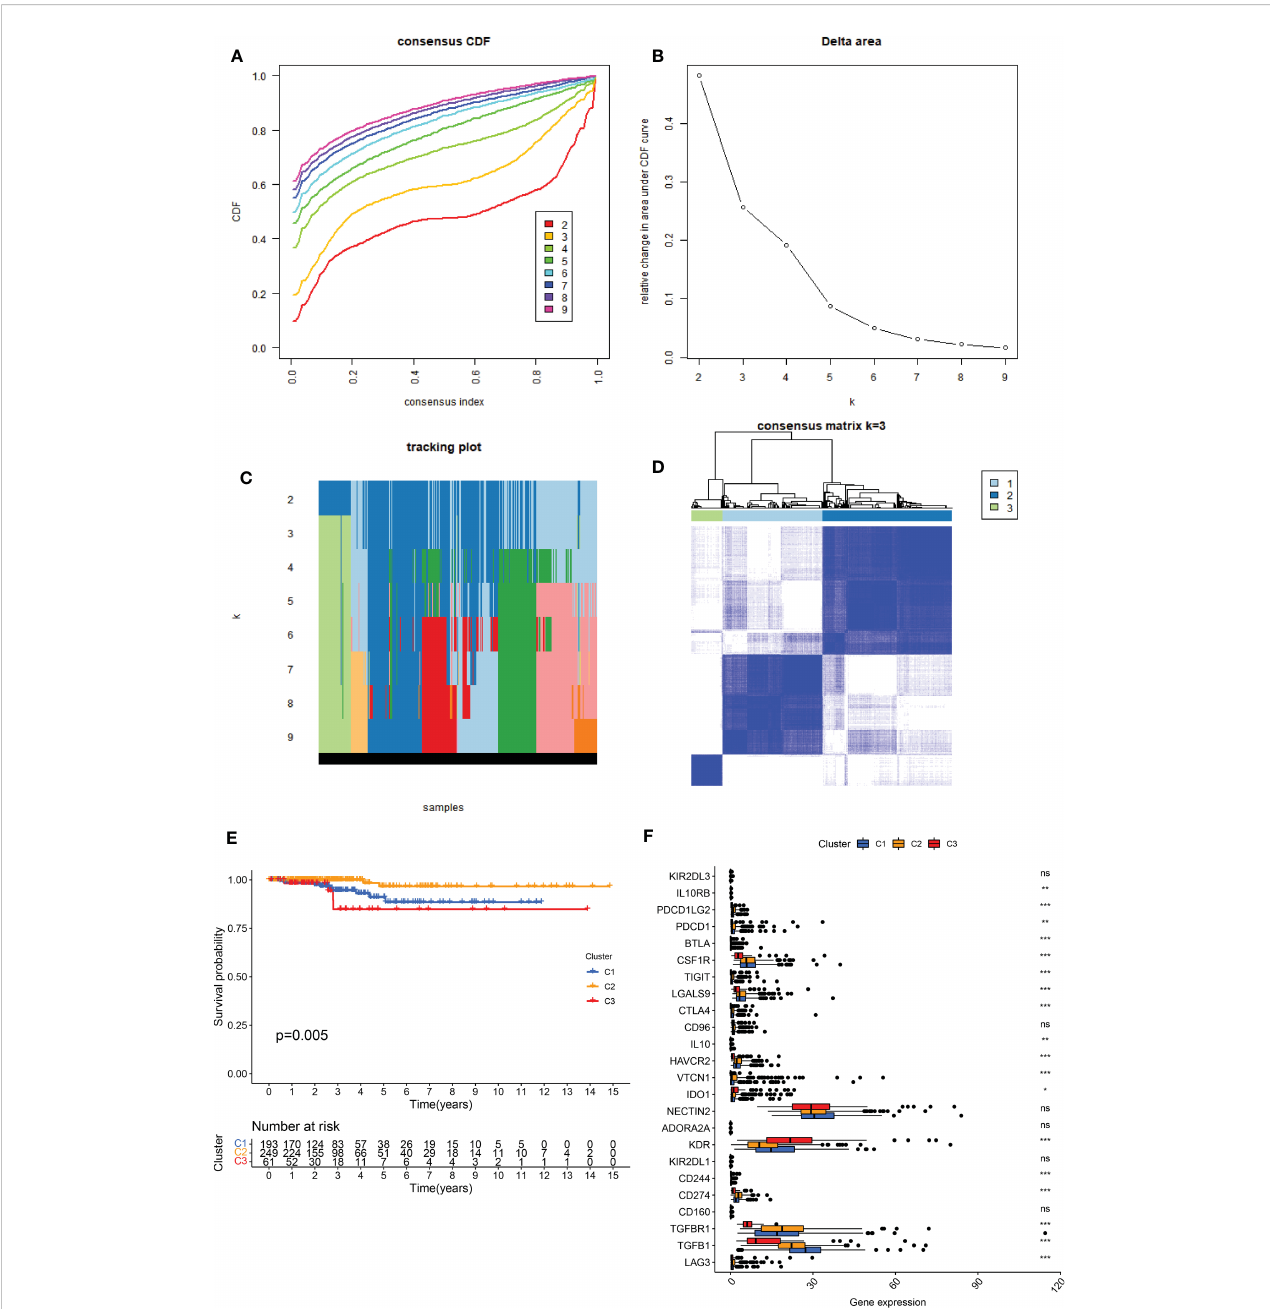
showing signi fi cant prognosis between the three clusters. (F) Boxplot presenting the signi fi cant expression difference of immune checkpoints between the three clusters. ns, no signi fi cance. * indicated P<0.05; ** indicated P<0.01; *** indicated